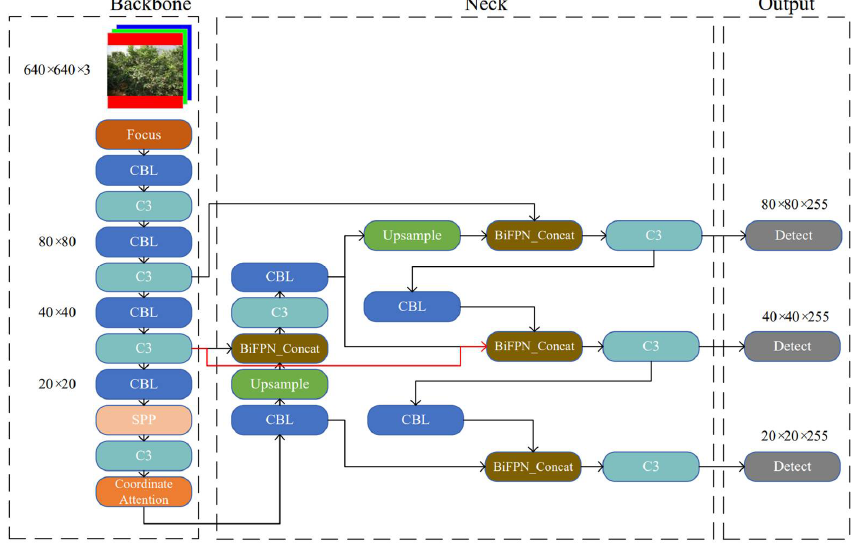
Figure 7. The network structure of the improved YOLOv5.